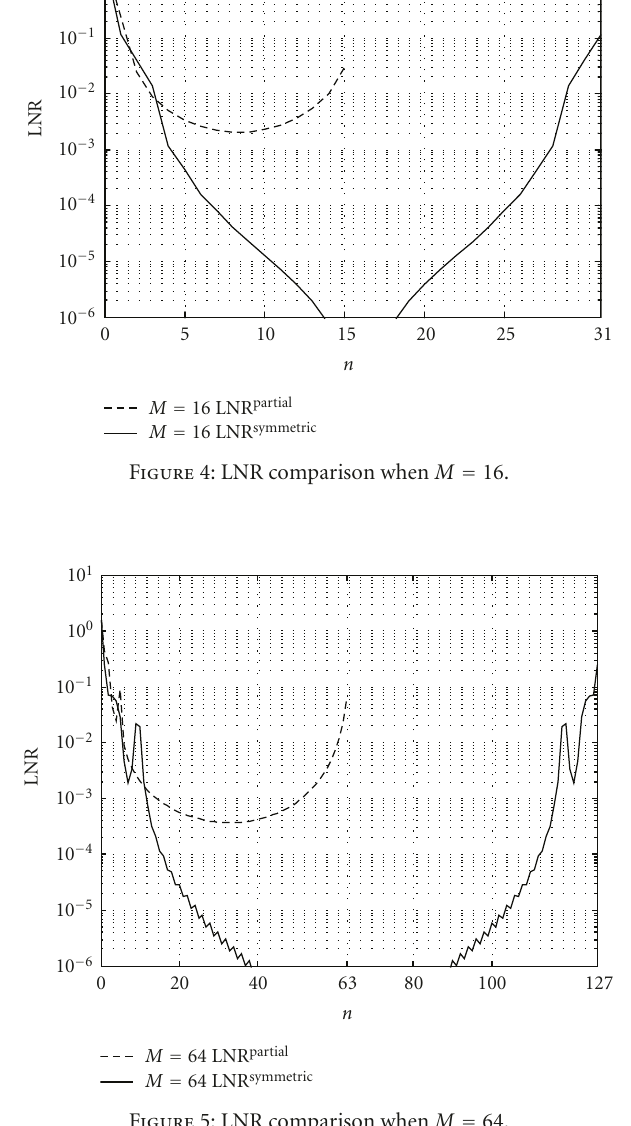
Figure 7: Theoretical upper bound of the MSE of our proposed symmetric extension DFT-based channel